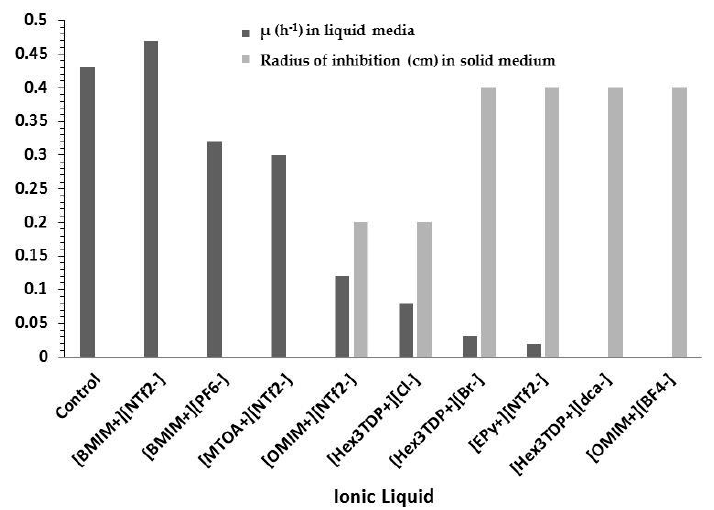
Figure 6. Growth rate of S. cerevisiae in liquid media with 3% of ionic liquid (v/v) ( ) and radius of inhibition in solid media ( ).